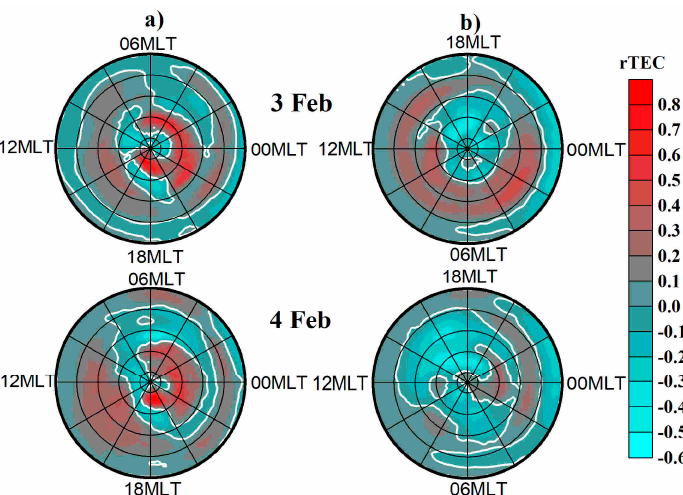
Figure 9. Mean relative TEC in magnetic latitude and magnetic local time coordinates. For 3 February 2022, the averaging is for the hours from 6 UTC to 18 UTC, and for 4 February 2022, from 8 UTC to 23 UTC. The color scale shows the rTEC values ( a , b ).